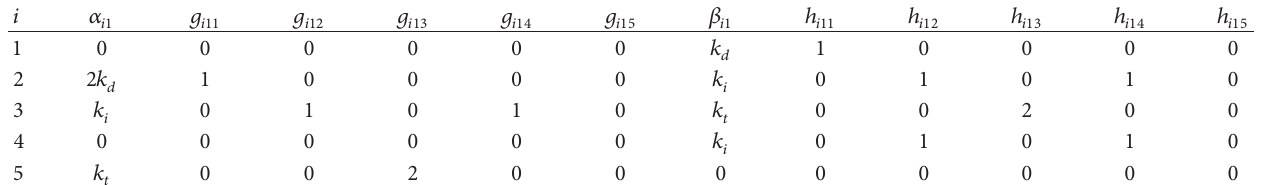
Table 1: Parameters of the interdiffusion model ( 𝑗 = 1).